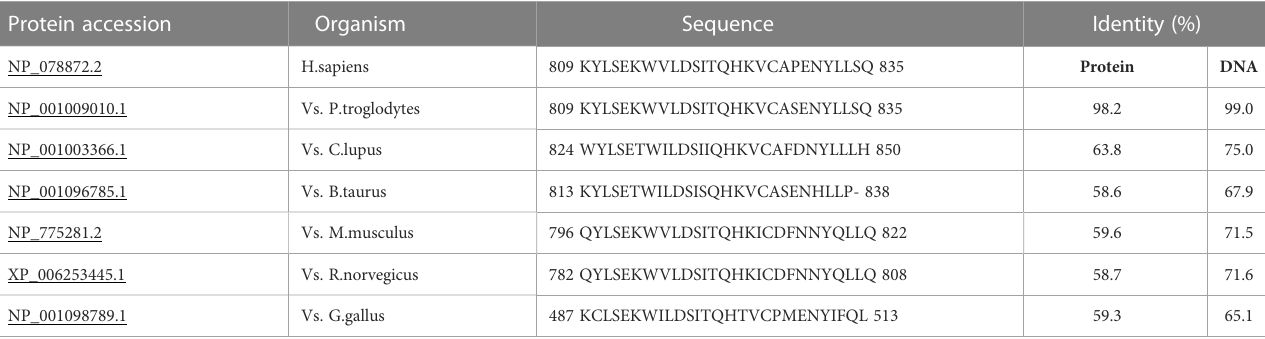
TABLE 1 Protein multiple alignment, pairwise similarity scores and evolutionary distances. Protein accession Organism